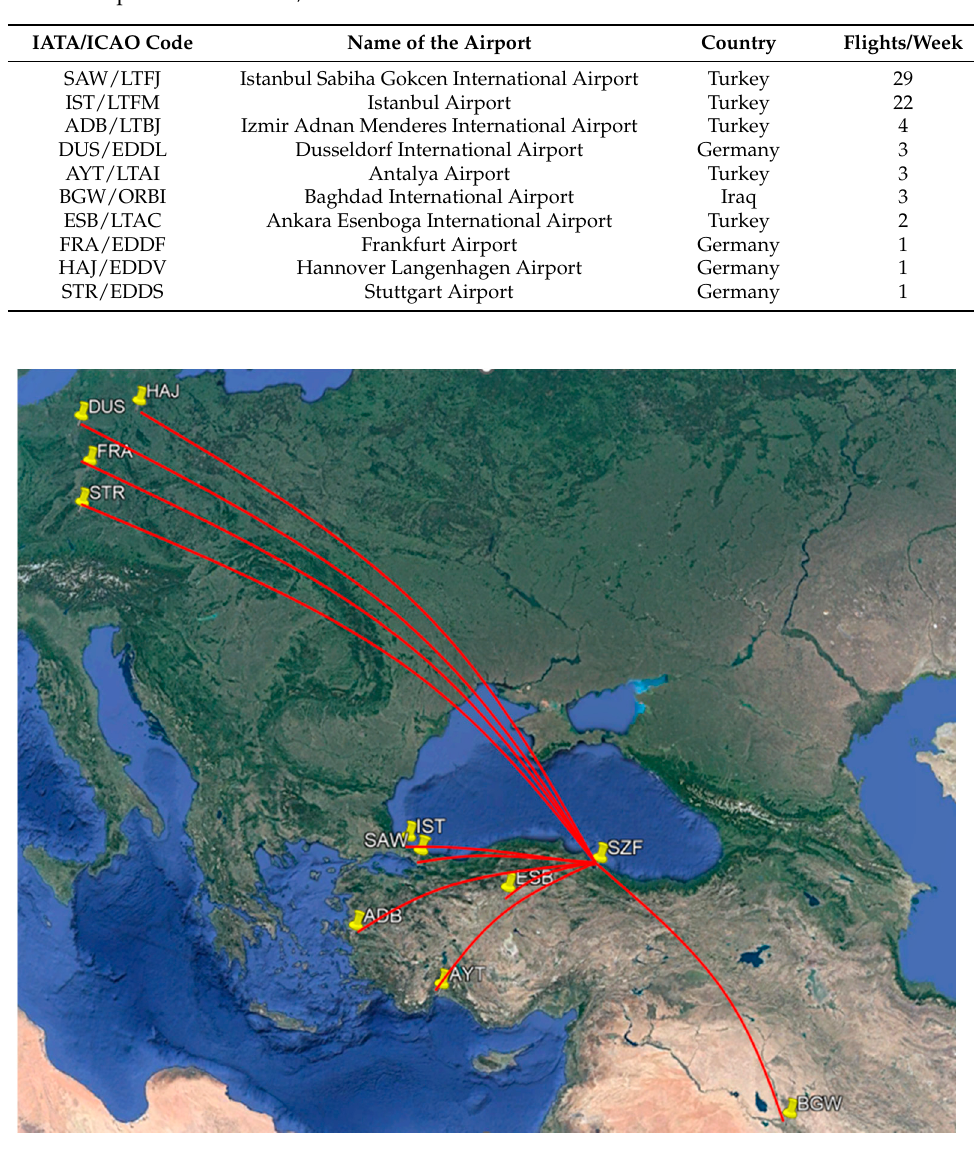
Figure 3. Visualization of top routes from SZF/LTFH.